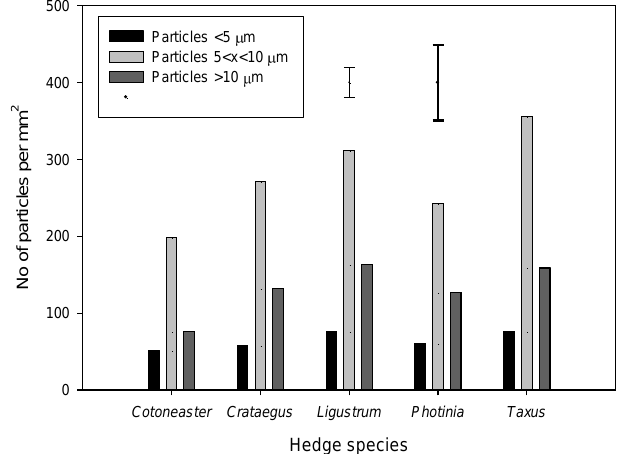
Figure 7. Mean number of particles on leaf surfaces (particles per mm 2 ) after a 9-day exposure to roadside traffic, in rain-free conditions for the five tested hedge species. Bars are mean of five replicates per species. Vertical error bars represent Least Significant Difference (LSD) of the means where the means were significantly different (<5 µm no significant differences, 5 < x < 10 μm LSD = 39.44, >10 μm fraction LSD = 98.57).